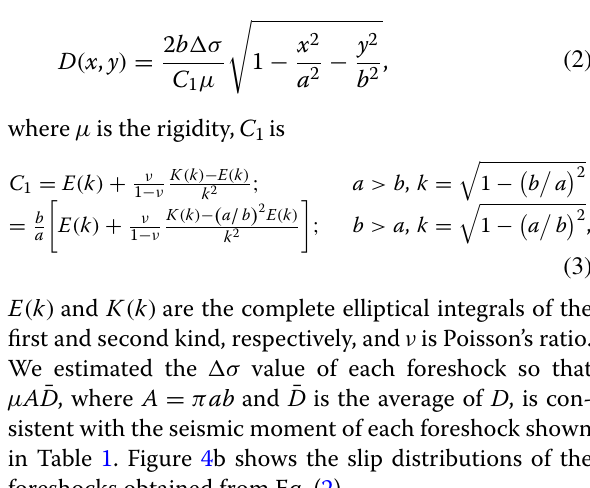
Table 1. The slip distribution of the elliptical crack with the constant stress drop �σ (Eshelby 1957) is